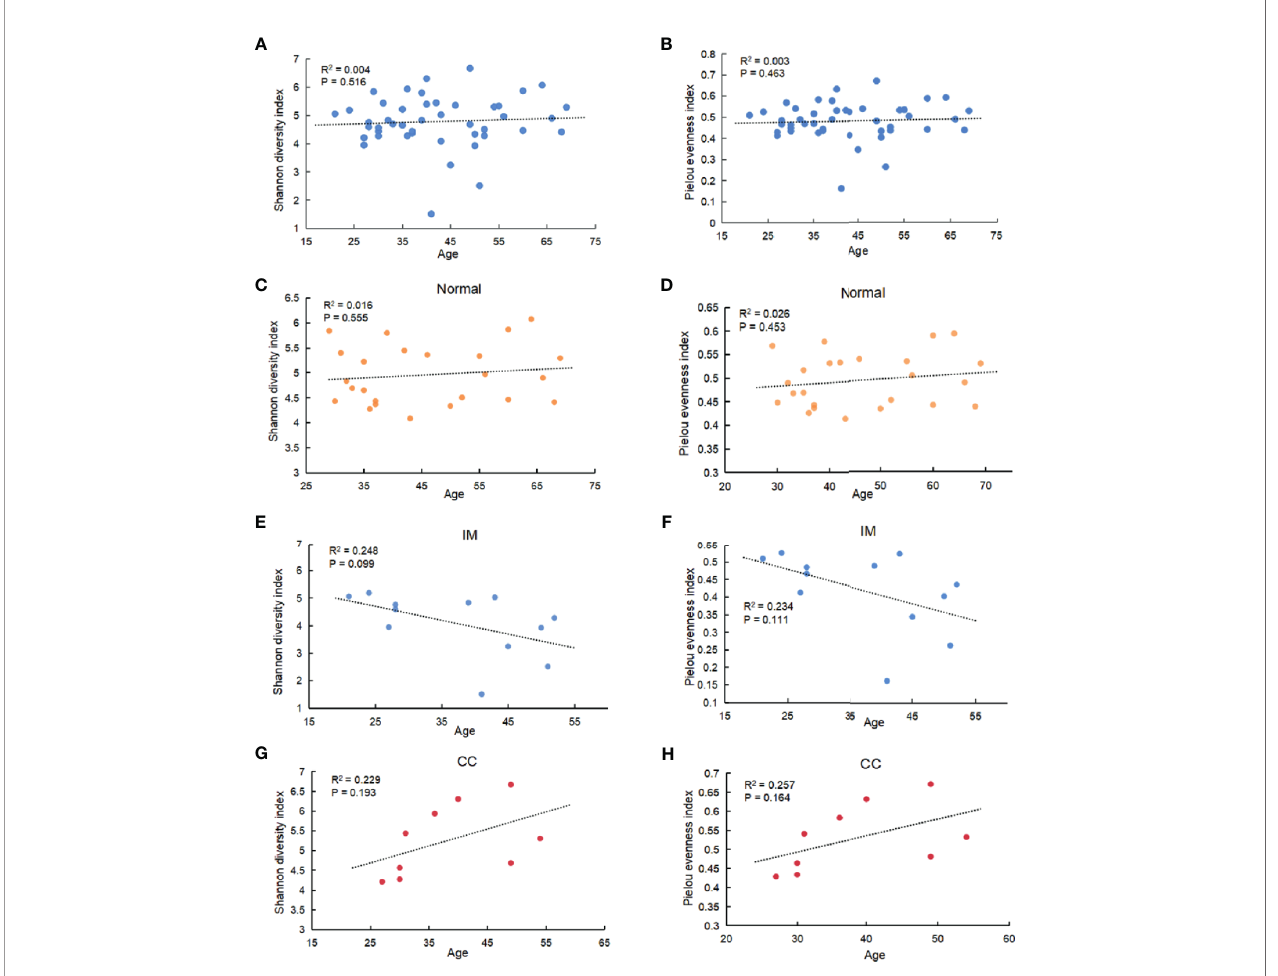
FIGURE 1 | Correlation between gut microbiota and age. (A) Among all subjects with different ages, a diversity was determined by the Shannon diversity index. (B) Among all subjects with different ages, a diversity was determined by Pielou evenness index. (C – F) Correlation between gut microbiota and age in IM, CC, and control group separately (C: Shannon diversity index in Normal group; (D) Pielou evenness index in Normal group; (E) Shannon diversity index in IM group; (F) Pielou evenness index in IM group; (G) Shannon diversity index in CC group; (H) Pielou evenness index in CC group). Results showed that no age-related effect on gut microbiota in each